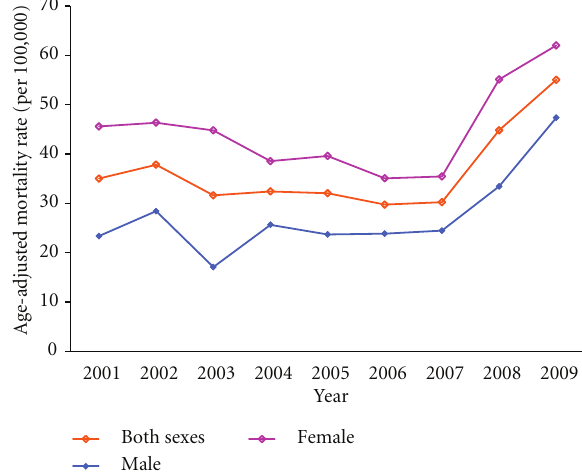
Figure 3: Age-adjusted ∗ mortality rates for dementia (per 100,000) among people aged 60 and above in Hong Kong, by sex, 2001–2009. ∗ The age-adjusted mortality rates used the Hong Kong population as of mid 2009 as the standard. Data sources: authors’ calculations based on data from Department of Health of Hong Kong